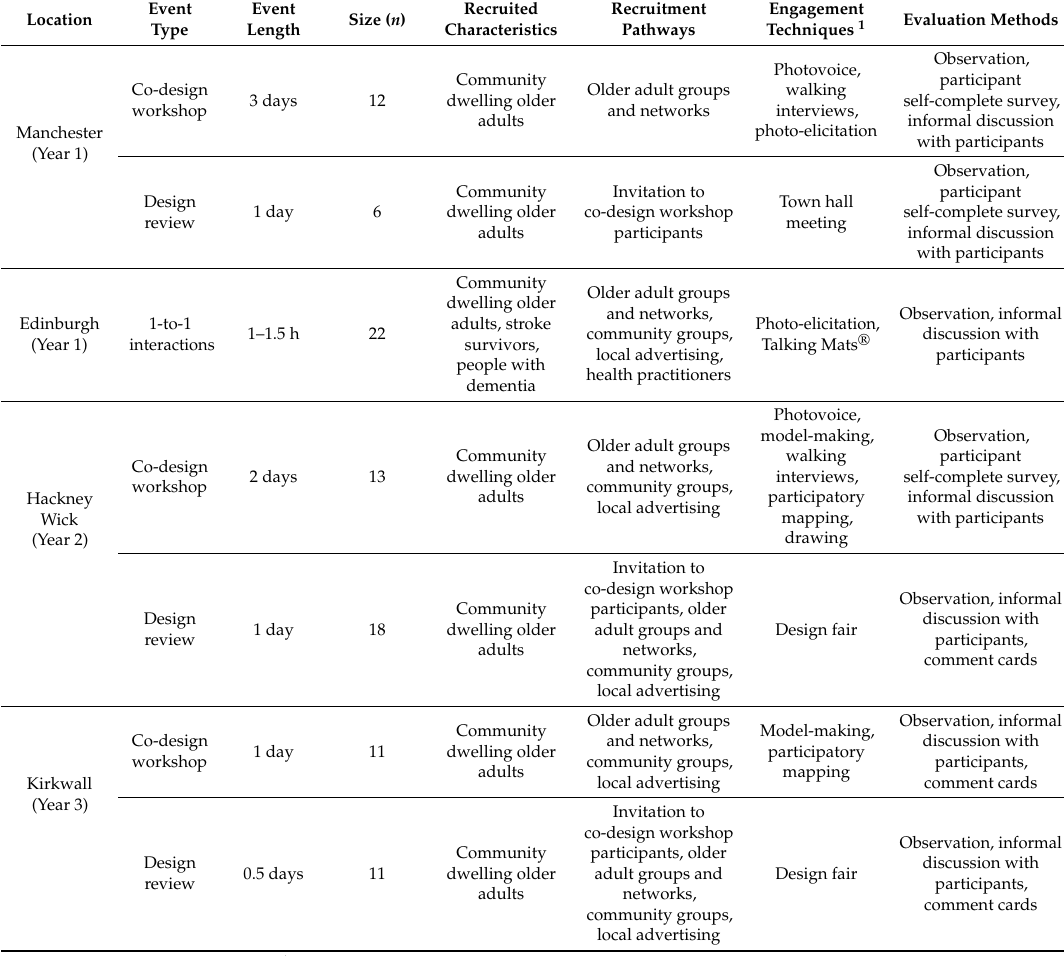
Table 2. Participatory design